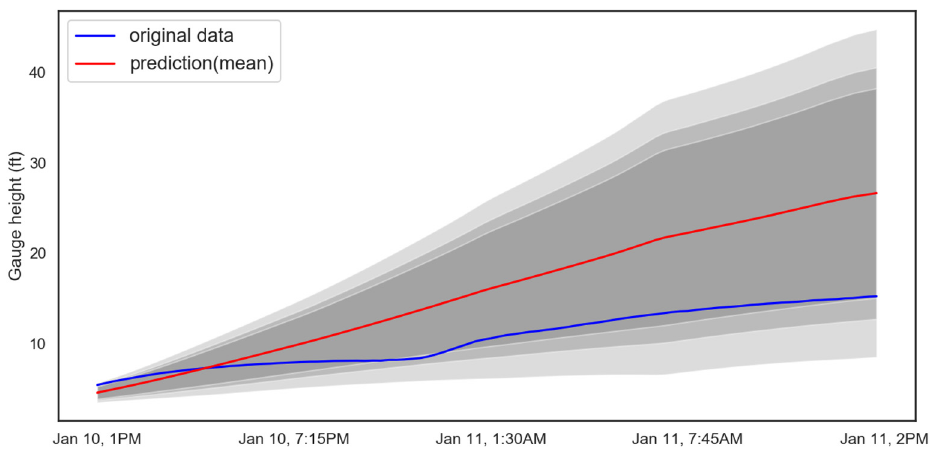
Figure 11. Forecasts of river level with uncertainty with increasing gauge.